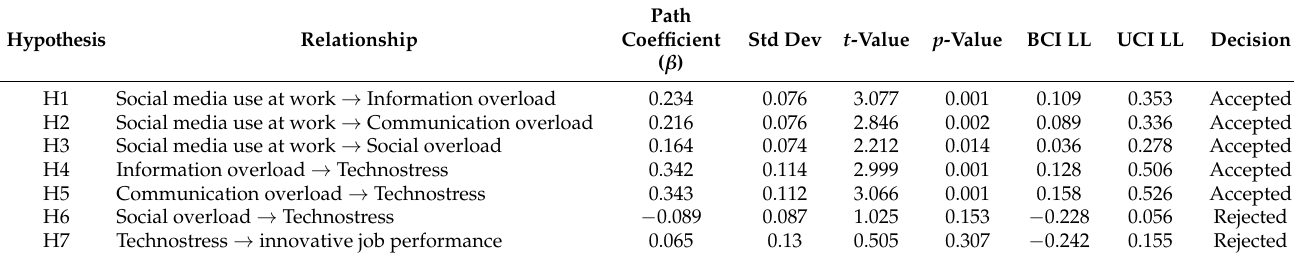
Table 8. Hypothesis